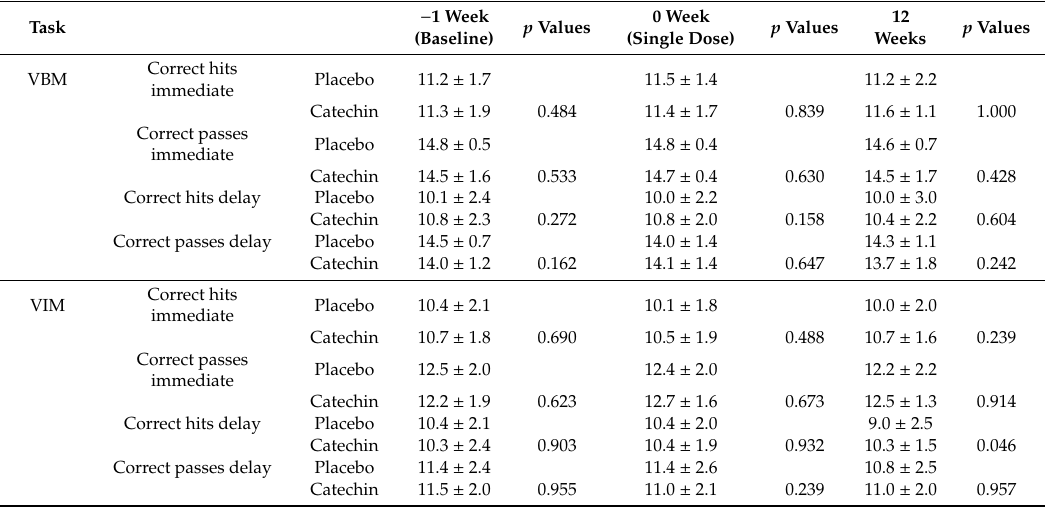
Table 2. E ff ects of green tea catechins on memory-related tasks.